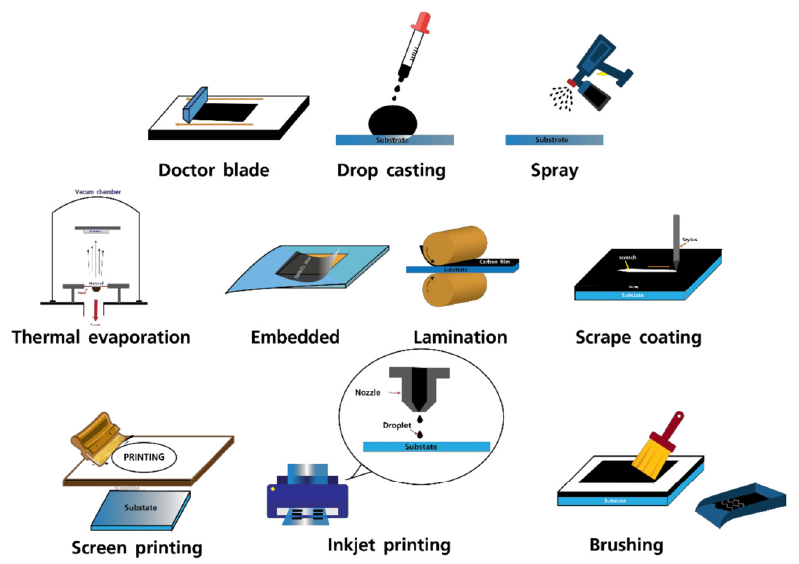
Figure 12. Schematic illustration of several techniques for fabrications of carbon electrodes in perovskite solar cells [81]. (Reproduced from Ref. [81], 10.3390/ma14205989, under the terms of the CC BY [4.0] license.)